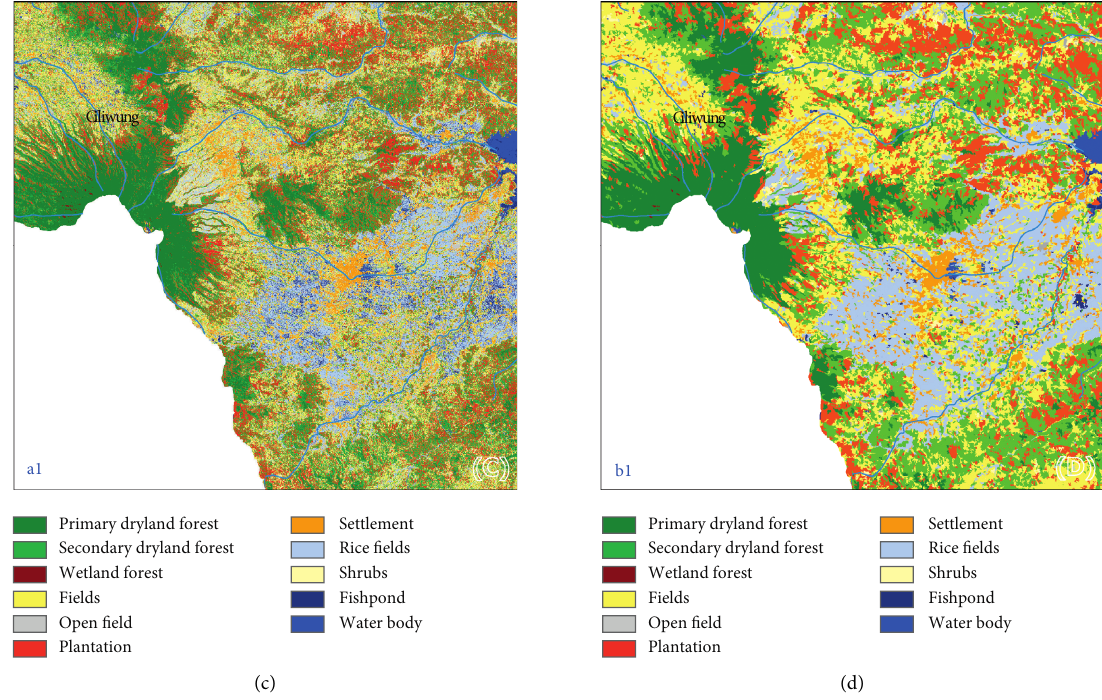
Figure 6: Results of the LULC classification based on the RF classifier: (a, c) process stages without the MaSegFil approach; (b, d) process stages with the MaSegFil approach.